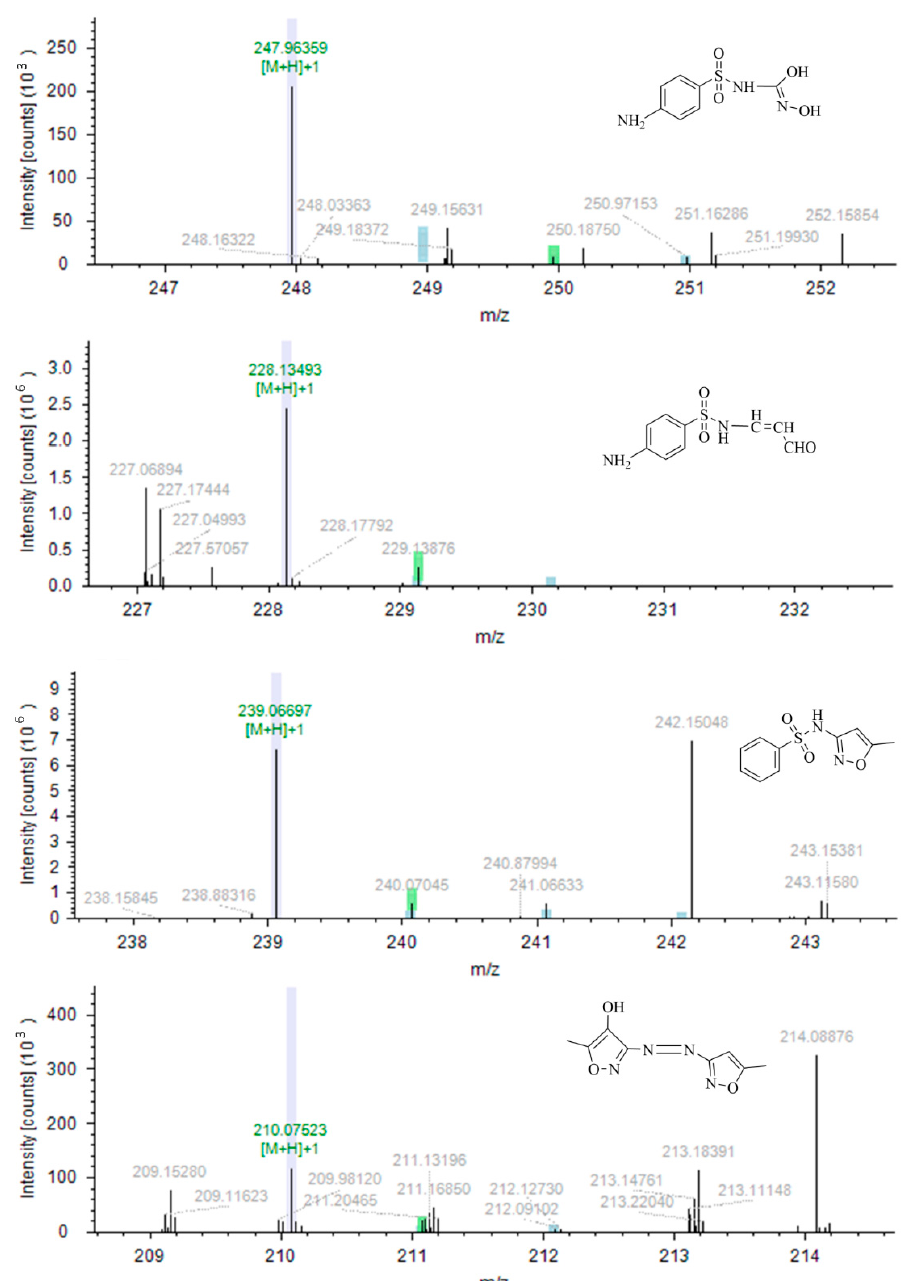
Figure 11. Intermediate product spectrum of SMX degradation.